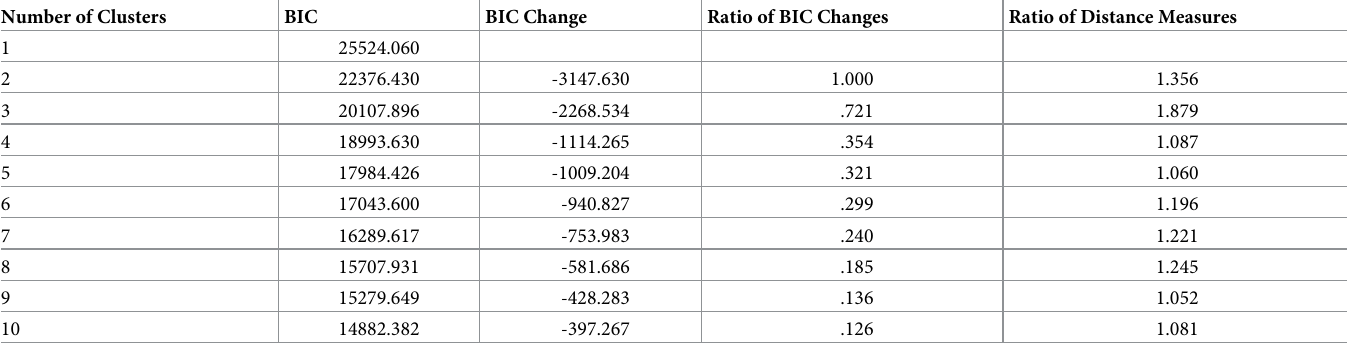
Table 4. BIC of two-step cluster